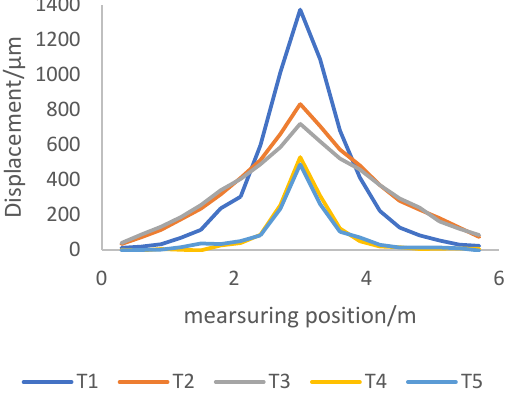
Figure 15. The measured deflection of test floors.